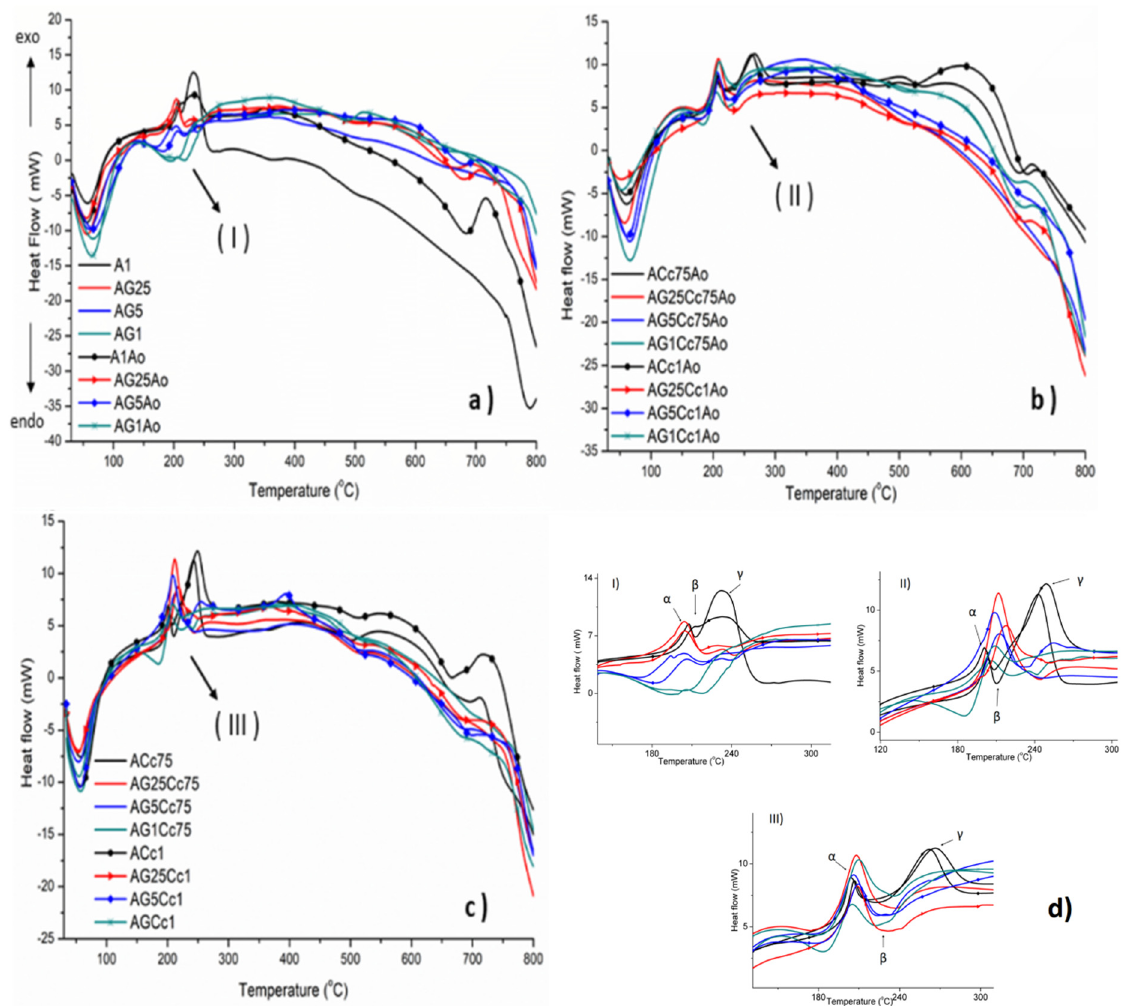
Figure 2: DSC thermograms: ( a ) none cross - linked and added with glycerol, without and with oleic acid; ( b ) cross - linked and added with glycerol; ( c ) cross - linked and added with glycerol and oleic acid; and ( d ) thermal transitions of phase 2 ( combination of α , β , and γ peaks ) in the three groups of bio fi